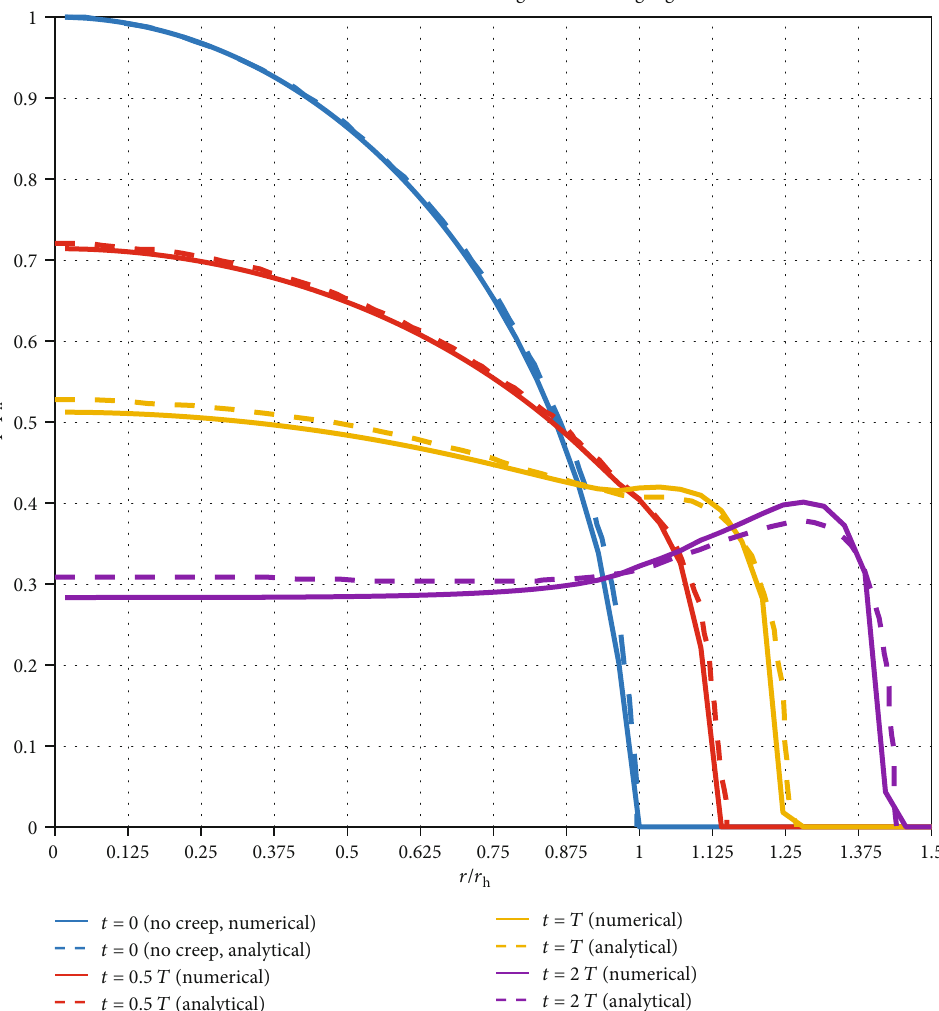
Figure 11: Comparison between analytical solutions ([39]; Johnson, 1985) and the numerical solutions for the Maxwell model. p the maximum pressure when the time is zero (no creep, the solution is Hertzian contact solution), and r contacting region when the time is